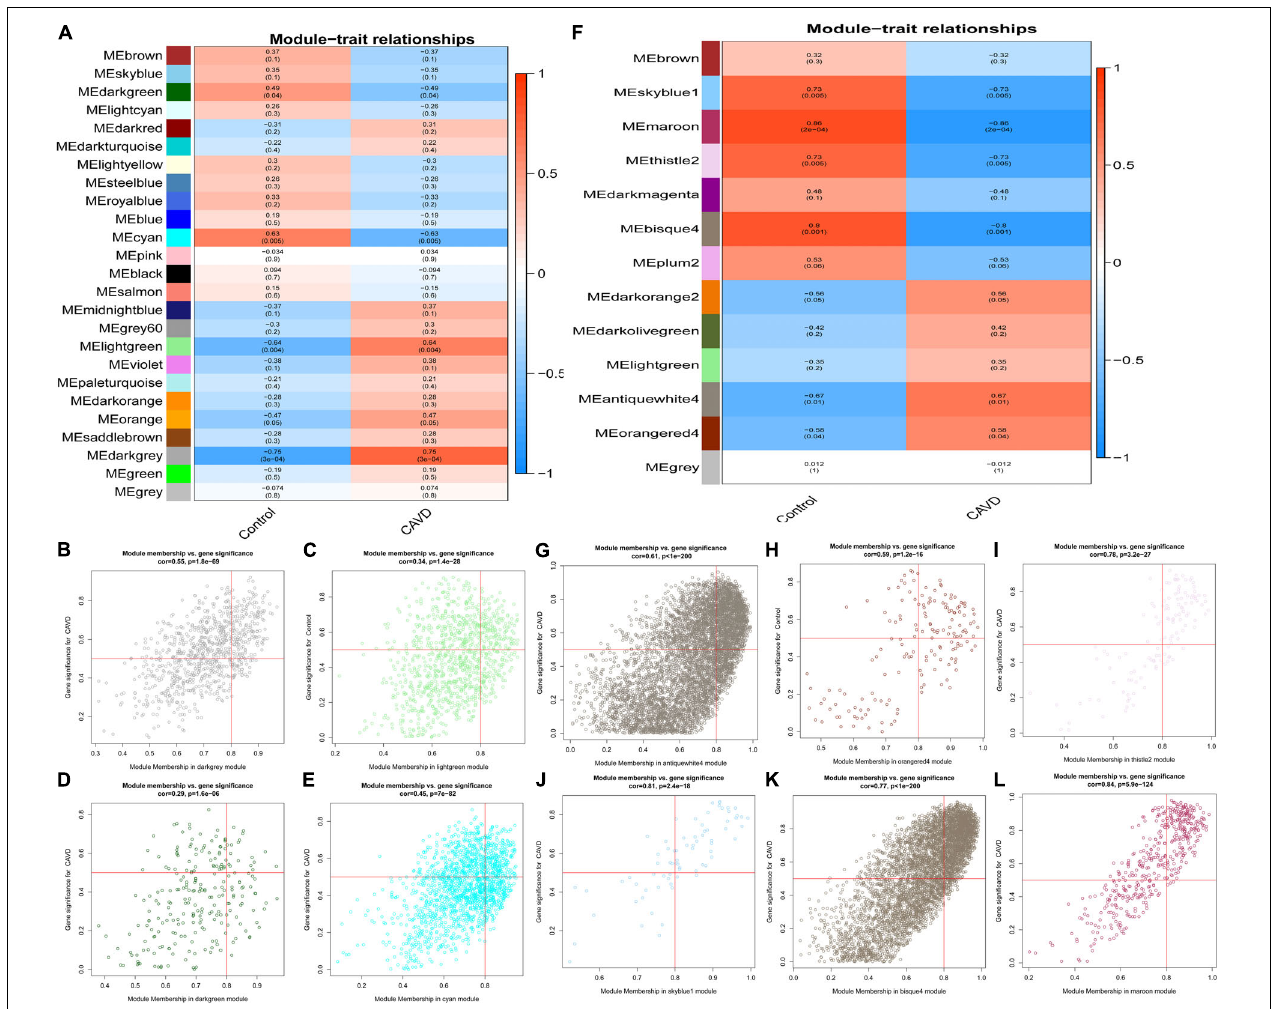
FIGURE 3 | The module-trait correlation heatmap and specific modules. Blue represents negative correlation, and red represents positive correlation. (A) The correlation between modules and CAVD in GSE55492; (B) dark gray module in GSE55492, (C) light green module in GSE55492; (D) dark green module in GSE55492; (E) cyan module in GSE55492; (F) The correlation between modules and CAVD in GSE148219; (G) antique white 4 module in GSE148219; (H) orange red 4 module in GSE148219; (I) thistle 2 module in GSE148219; (J) sky blue 1 module in GSE148219; (K) bisque 4 module in GSE148219; (L) maroon module in